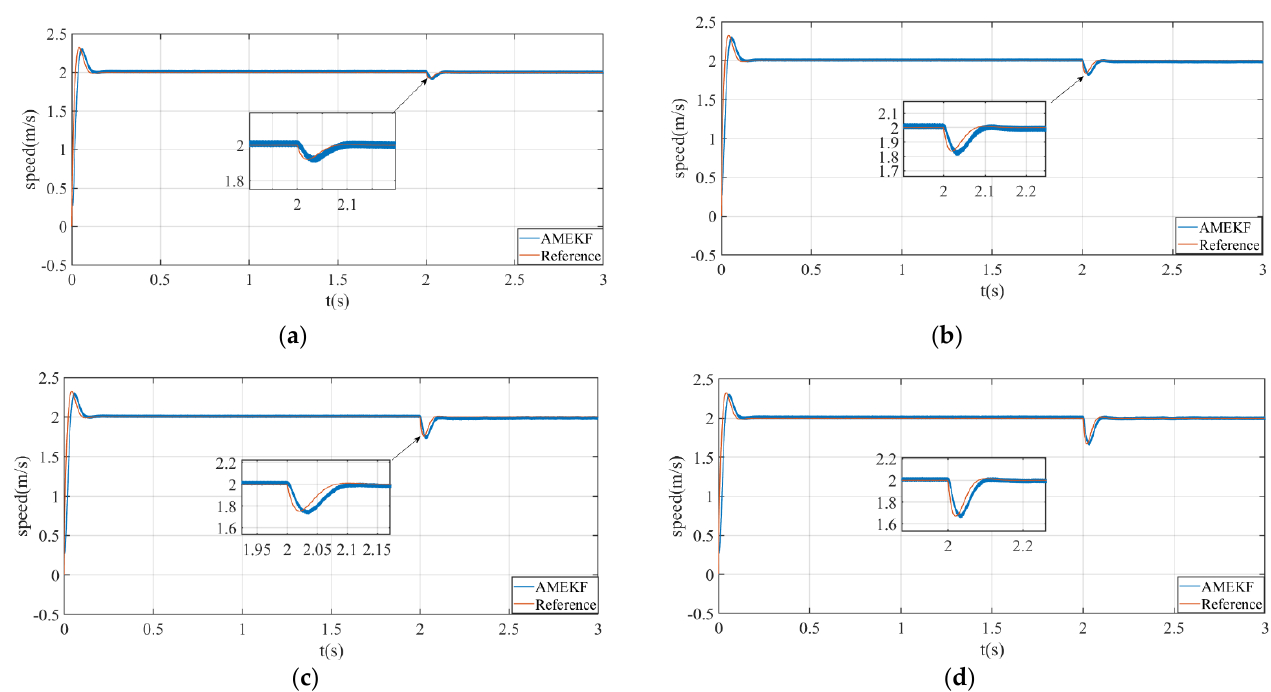
Figure 8. Comparison of velocity estimation under sinusoidal condition. ( a ) Actual speed and esti- mated speed under EKF algorithm. ( b ) Actual speed and estimated speed under AMEKF algorithm. ( c ) EKF velocity estimation error. ( d ) AMEKF velocity estimation error.